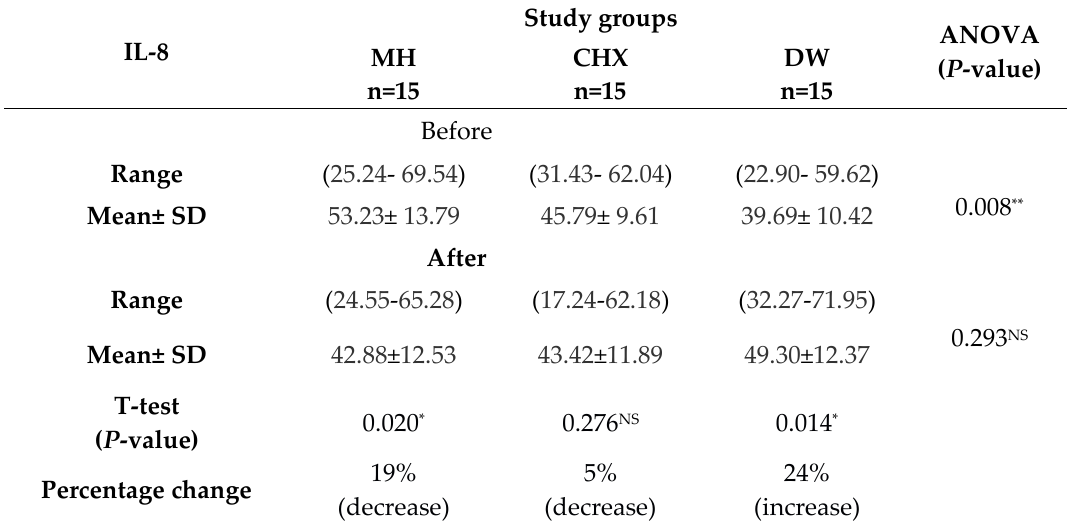
Table 4: Mean value of IL-8 in study groups before and after mouthwash